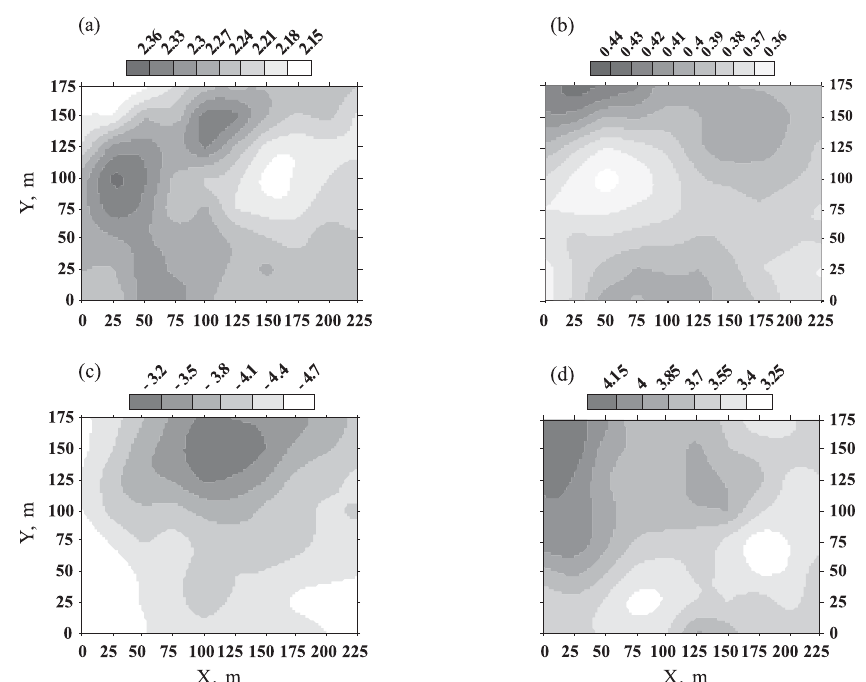
Figura 5. Mapas de isolinhas do Neossolo Flúvico: (a) n , (b) θθθθθ